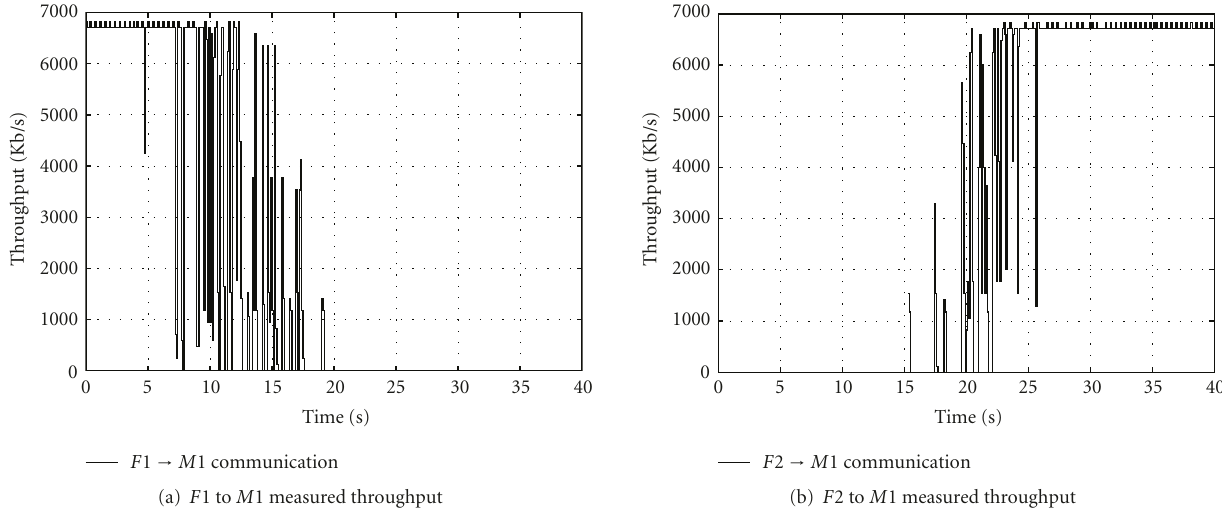
Figure 19: Emulation results with a hidden terminal